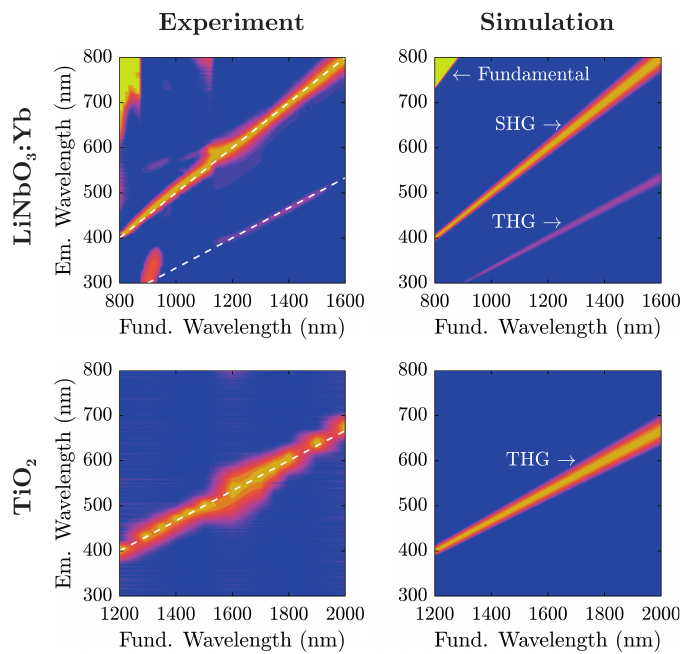
Figure 5. ( Left ): baseline-corrected emission spectra of LiNbO 3 :Yb- ( top ) and TiO 2 -nanopowder ( bottom ) as a function of the fundamental wavelength. Dashed lines indicate SHG- and THG-peak positions. Each spectrum’s most significant peak has been scaled to unity; ( Right ): simulated spectra with their respective emission characteristics based on the spectral properties of the fundamental beam. All spectra are plotted on a logarithmic intensity scale with values exceeding unity clipped to one. Values scale from blue over red to yellow.